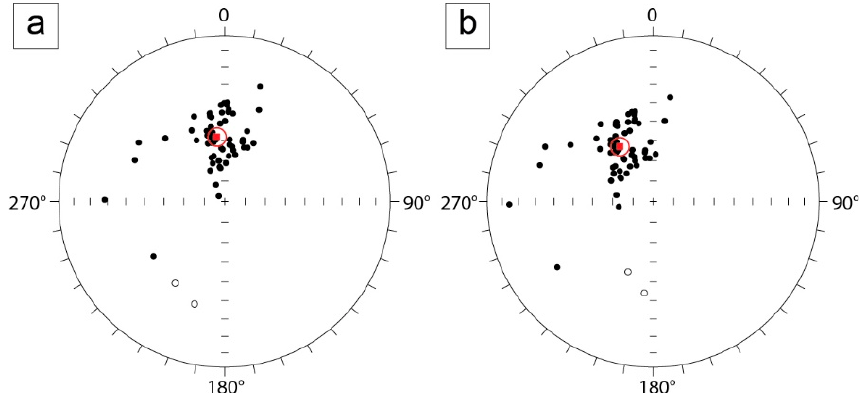
Figure 8. Equal-area projections of the ChRM component directions from palaeomagnetic samples from section H in ( a ) in situ (geographic) and ( b ) tilt-corrected coordinates. In red, mean direction (square) with a95 confidence. Table 1. Palaeomagnetic mean directions from samples collected along section H (Figure 7). N: number of samples; k: Fisher precision parameter; a95: radius of the cone of 95% confidence; Dec.: mean Declination of the ChRM component; Inc.: mean Inclination of the ChRM component. Mean Directions In Situ Tilt-Corrected N k a95